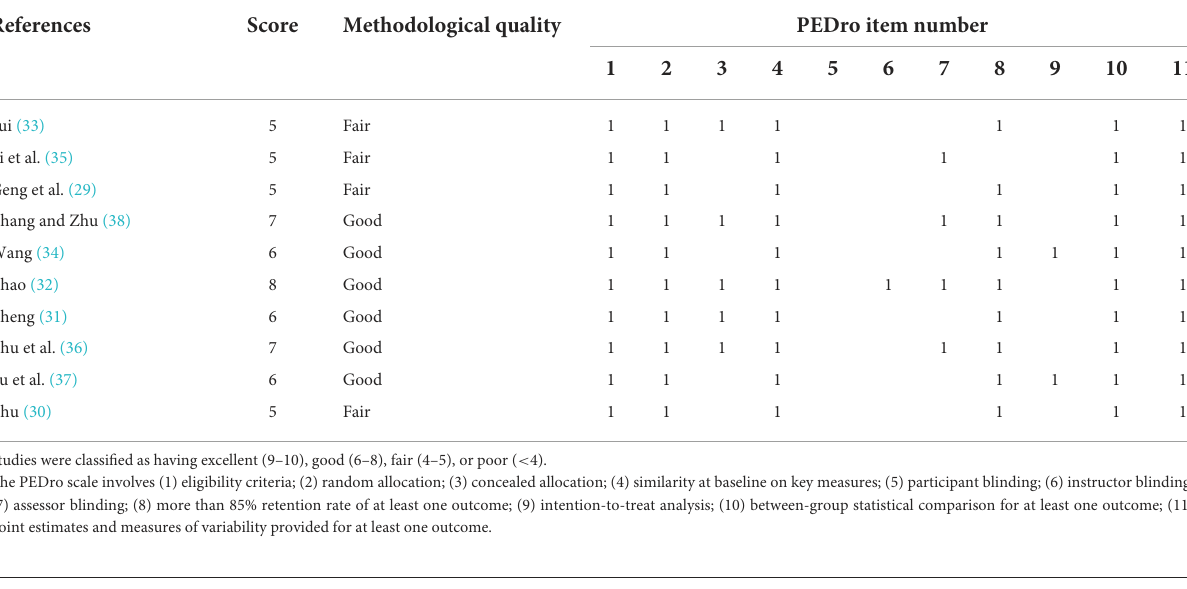
TABLE 2 Methodological quality of the included studies.